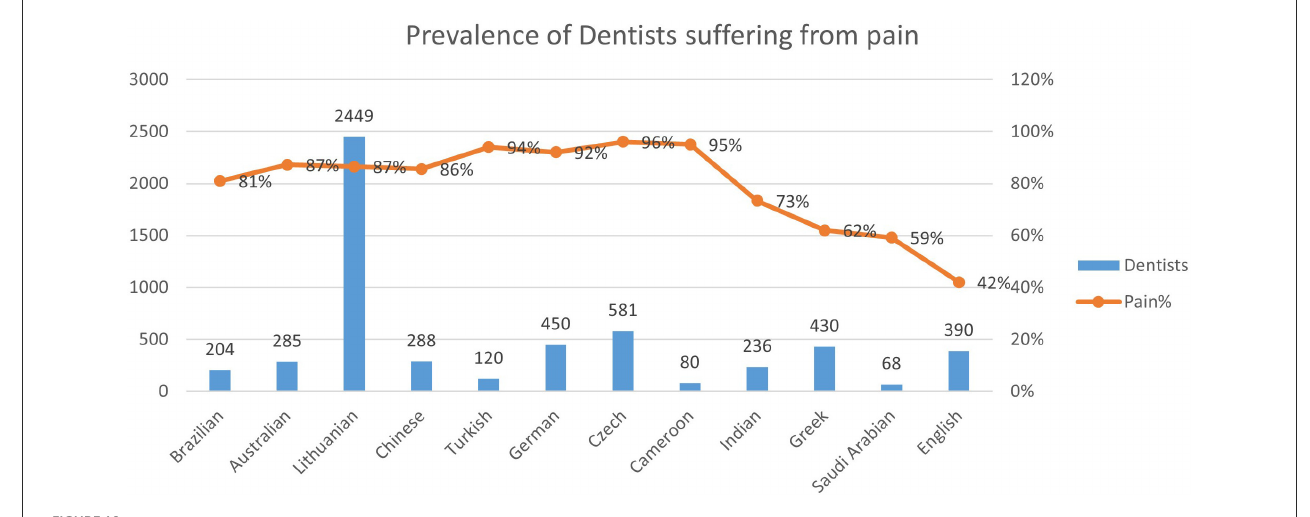
FIGURE10 Previous studies showing the prevalence of dentists suffering from musculoskeletal pain.